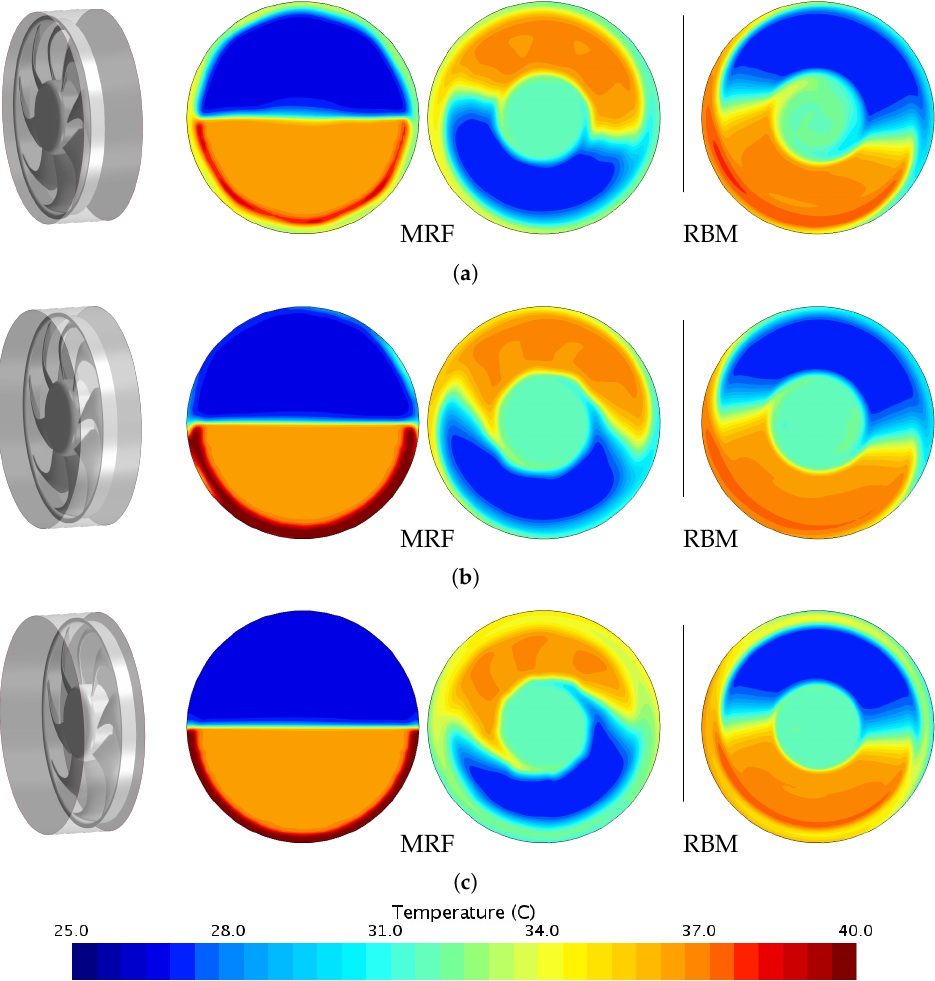
Figure 7. Temperature field up- and downstream of the fan region for varying fan blade positions in respect to the interfaces performed with the MRF ( middle ) and RBM approach ( right ). The length of the fan region is L MRF = 120mm and the fans rotational speed is 2800rpm. ( a ) Blades placed close to the upstream interface; ( b ) blades placed in the centre of the domain; ( c ) blades placed close to the downstream